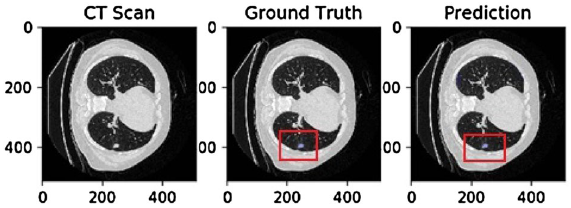
Figure 2. MSD lung tumor segmentation results.